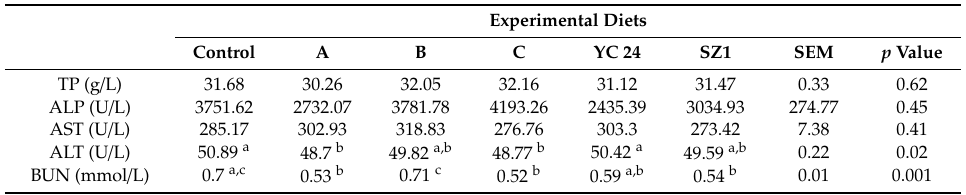
Table 8. E ff ects of di ff erent dietary treatments on some plasma biochemical parameters of broilers over 42 days.